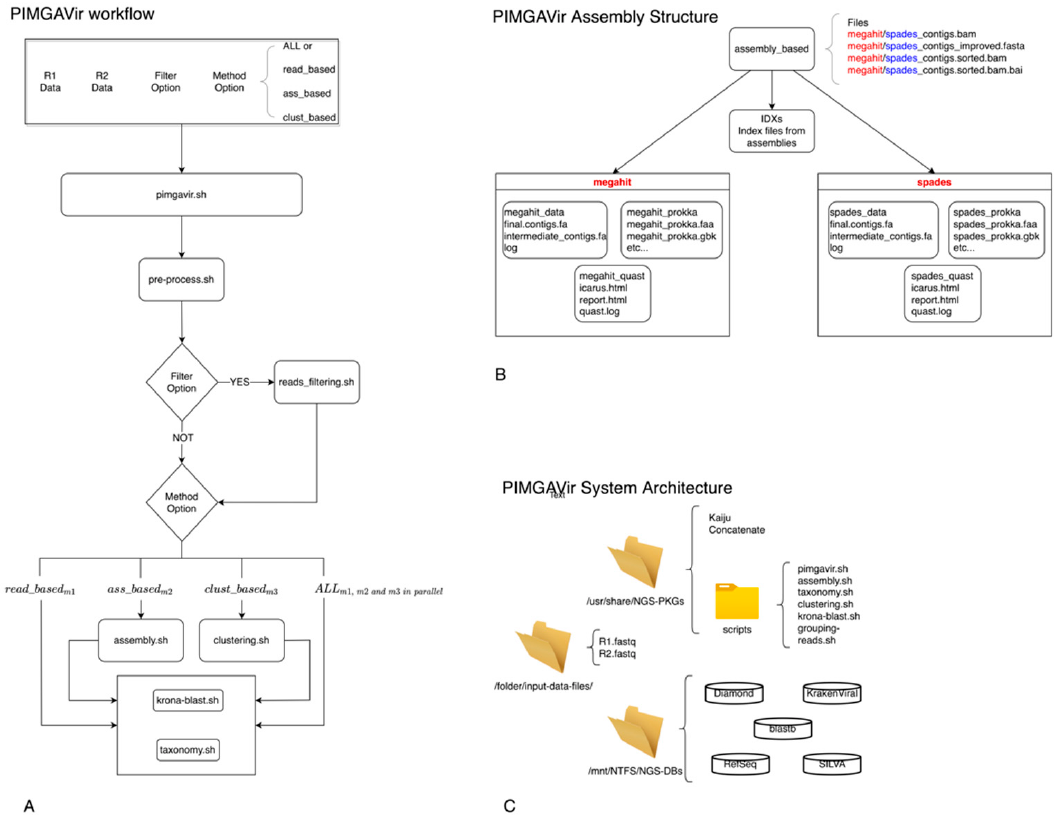
Figure 1. PIMGAVir pipeline. ( A ) PIMGAVir flowchart showing the pre-processing task, the fil- tering option, the execution of the three strategies and the taxonomic classification. ( B ) Example of the data structure organization for the ass_based strategy. ( C ) Simplification of the PIMGAVir system